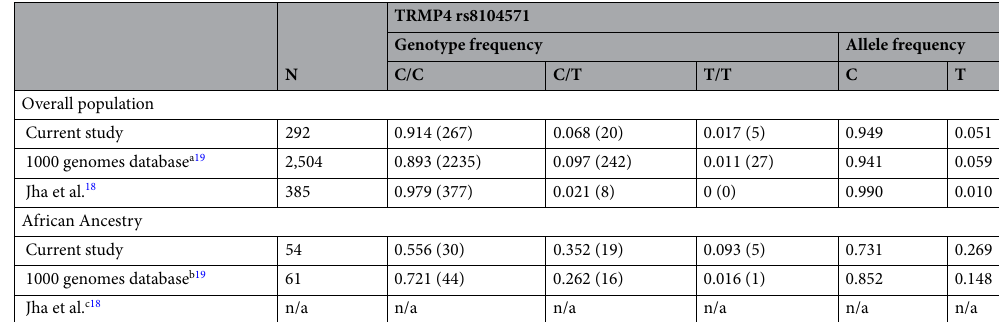
Table 1. TRMP4 rs8104571 genotype and allele distribution comparison between our study, the 1000 Genomes Project, and an investigation by Jha et al., 2019, presented as frequency (n). C cytosine, T